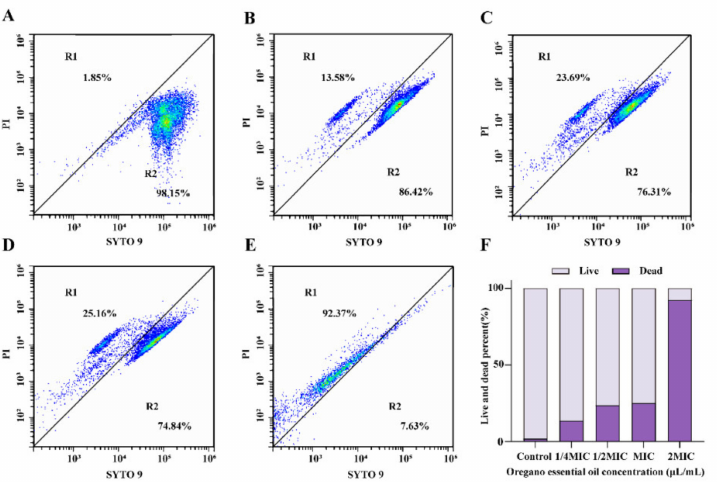
Figure 7. Flow cytometry observations of OEO’s effects on the cell membrane integrity of E. faecalis ATCC 29212. ( A ) Untreated. ( B ) Treated with OEO at 1/4 MIC. ( C ) treated with OEO at 1/2 MIC ( D ) treated with OEO at MIC. ( E ) treated with OEO at 2 MIC. ( F ) Live and dead cell percentage. Cells were stained with SYTO9 and PI simultaneously. R1: dead or membrane-damaged cells. R2: living cells.